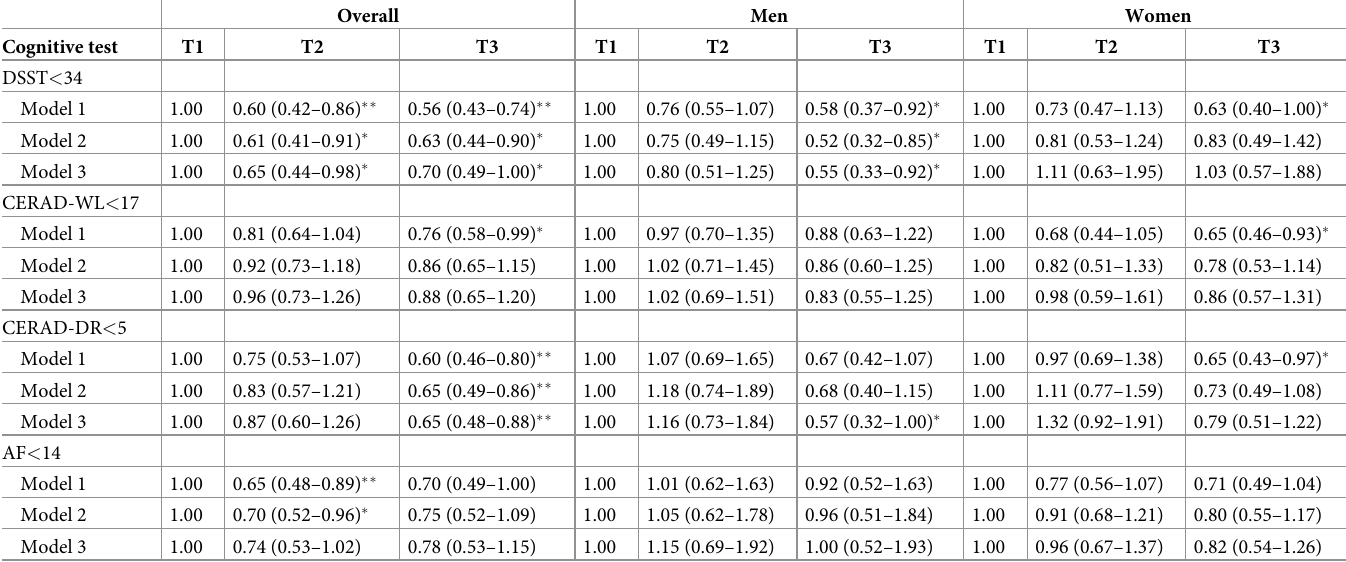
Table 2. Odds ratio (95% confidence intervals) of cognitive impairment by tertiles of serum iron concentrations. Overall Men Women Cognitive